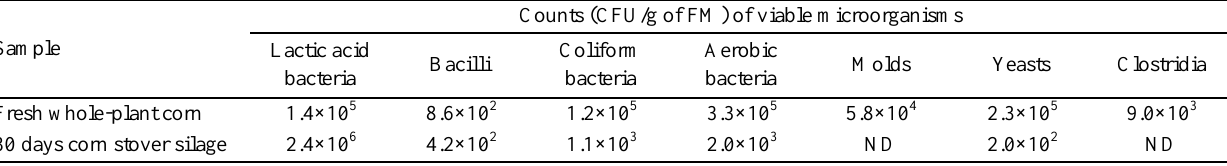
Table 1. Microbiological analysis of the fresh whole-plant corn and 30 days silage